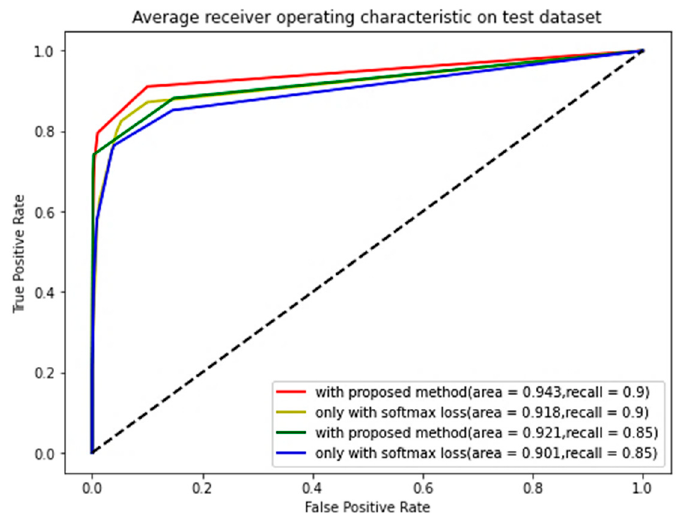
Figure 9. ROC curves are described by the CNN-AE with softmax loss and center loss and CNN-AE with softmax loss when the recall is 0.85 and 0.9.